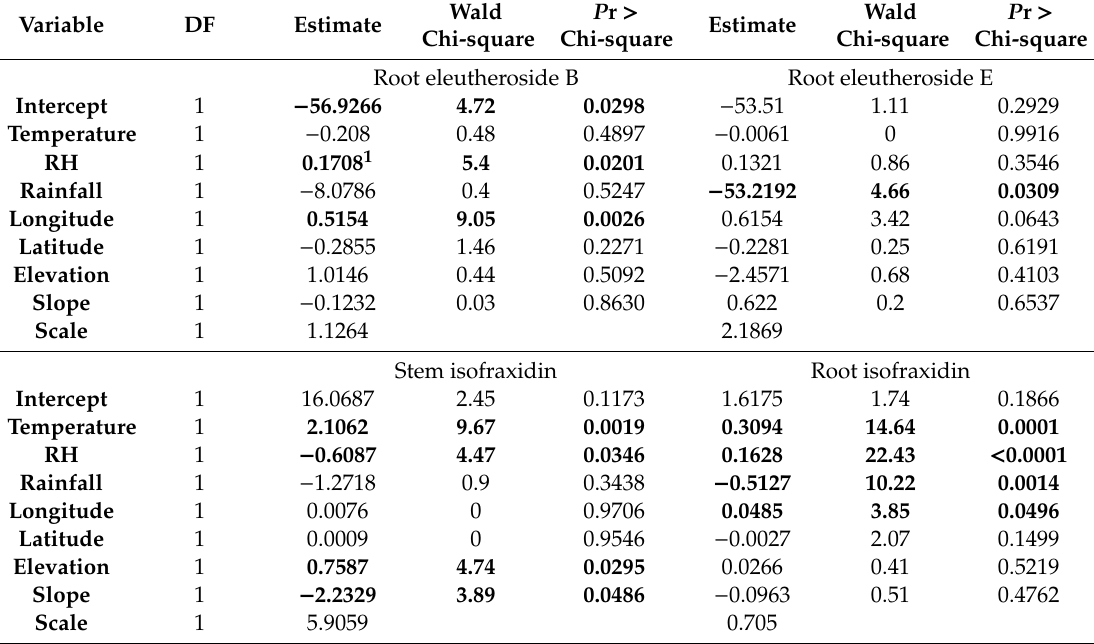
Table 5. Maximum-likelihood regression of variables about climate and topography on eleutheroside B and E concentrations in roots and isofraxidin content in stem and root in Eleutherococcus senticosus plants.